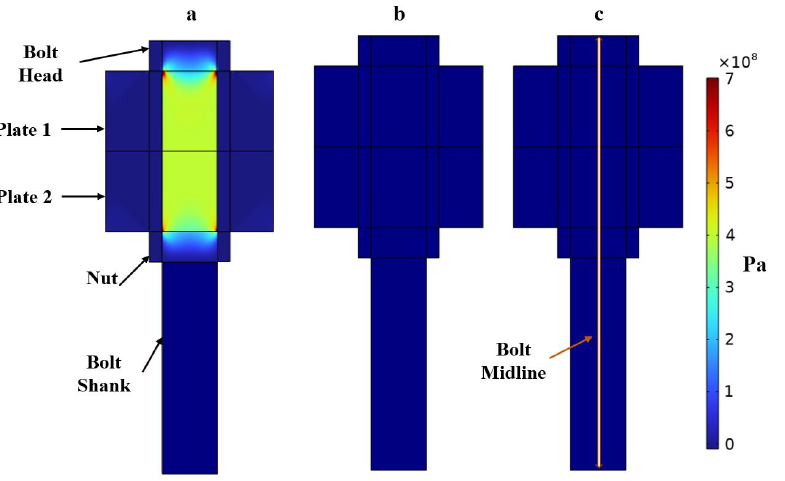
Figure 4. Stress distribution on a cross-section of the bolted joint under a pre-tensioning level of 450 MPa. ( a ) T 11 , ( b ) T 12 and ( c ) T 13 . It can be noticed that the shear stress T 12 and T 13 are by far much smaller and negligible with respect to T 11 .